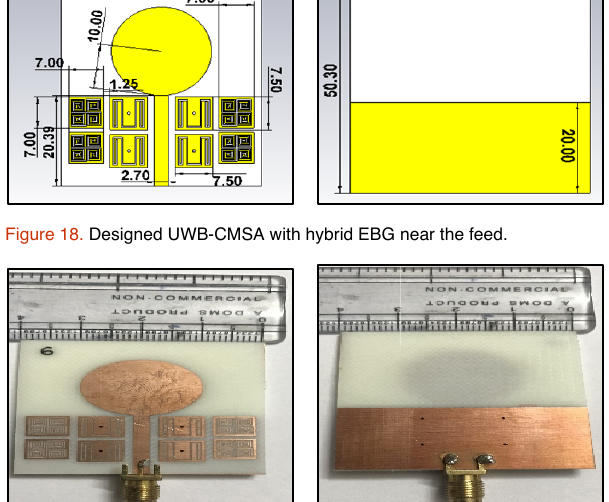
Figure 19. Fabricated UWB-CMSA with hybrid EBG near feed.